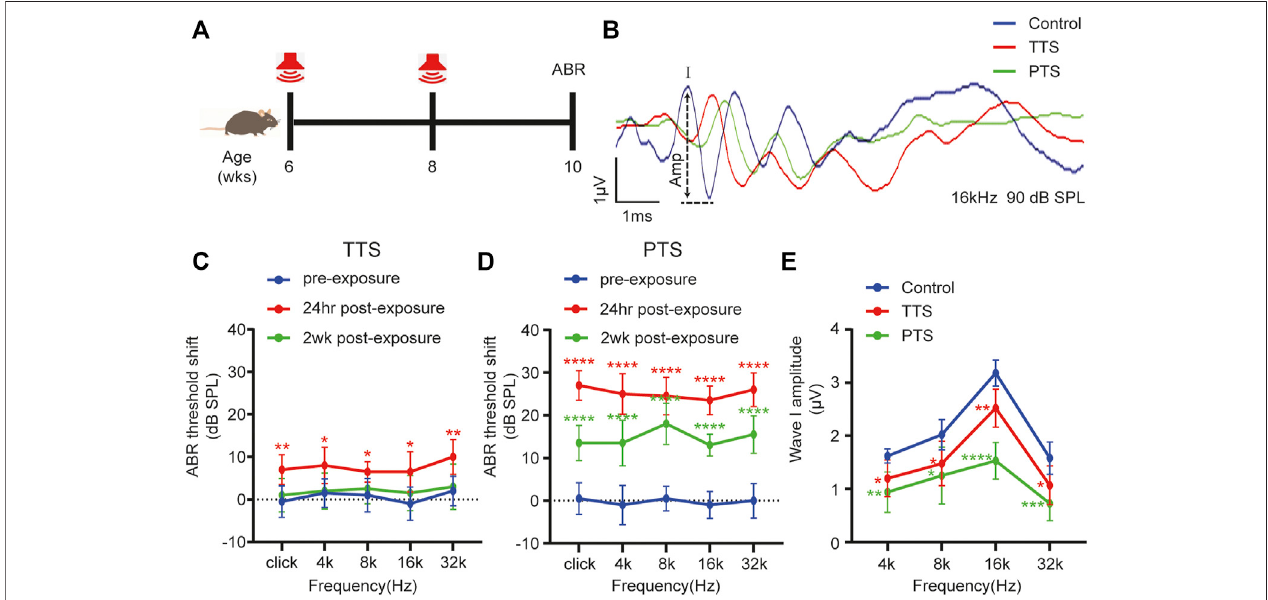
FIGURE1| ChangesinABRthresholdsandI-waveamplitudesafteroneortwoNEs. (A) MiceunderwentNEat6and8weeksofageoronlyat8 weeksofage,and ABR testing was performed at 10 weeks of age. (B) Overlapped ABR waves were recorded in response to 16 kHz 90 dB SPL stimuli in control, TTS and PTS mice. (C) ABR test showing changes in the hearing thresholds of mice in the TTS group before NE and at 24 h and 2 weeks after NE. (D) ABR test showing changes in hearing thresholds of mice in the PTS group before NE and at 24 h and 2 weeks after NE. (E) ABR test showing changes in I-wave amplitude after NE. ( n (cid:1) 10 per group). ABR, auditory brainstem response; NE, noise exposure; TTS, temporary threshold shift; PTS, permanent threshold shift. * p < 0.05; ** p < 0.01; *** p < 0.001; **** p <